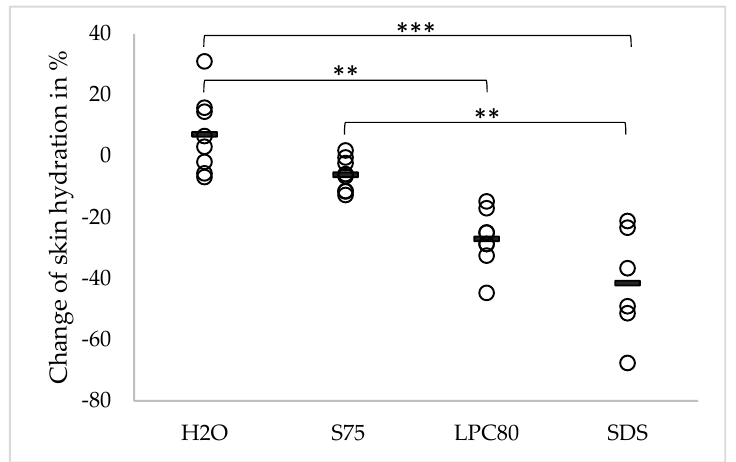
Figure 3. Effect of water and the three different surfactants lecithin S75, lecithin LPC80 and SDS on skin hydration after four days of repeated exposure. Parameter changes were calculated using Equation (1) and are expressed as single values ( n = 8, SDS values n = 6) and the corresponding mean. Statistically significant differences are marked with asterisks (** p < 0.01, *** p < 0.001) and were tested with a one-way ANOVA + post-hoc Tukey test with p < 0.05 as minimum level of sig- nificance.